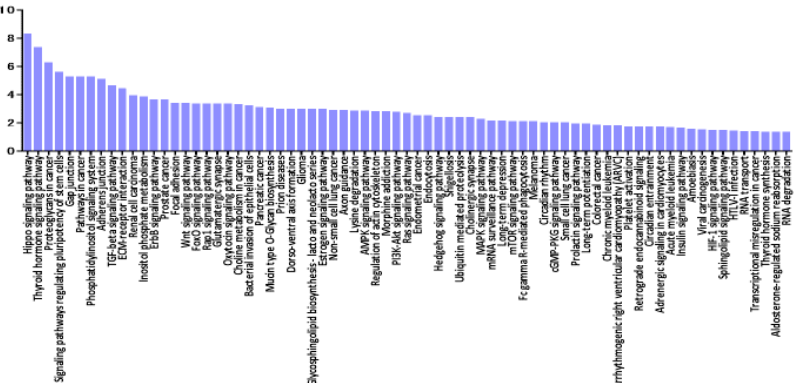
Figure 4. Histogram presenting pathways enriched in genes targeted by VRL-modulated miRNAs and differentially expressed miRNAs in serum of VRL patients compared with macular hole/epiretinal membrane patients. y axis: − log 10 ( p -value). TGF: transforming growth factor, GABA: